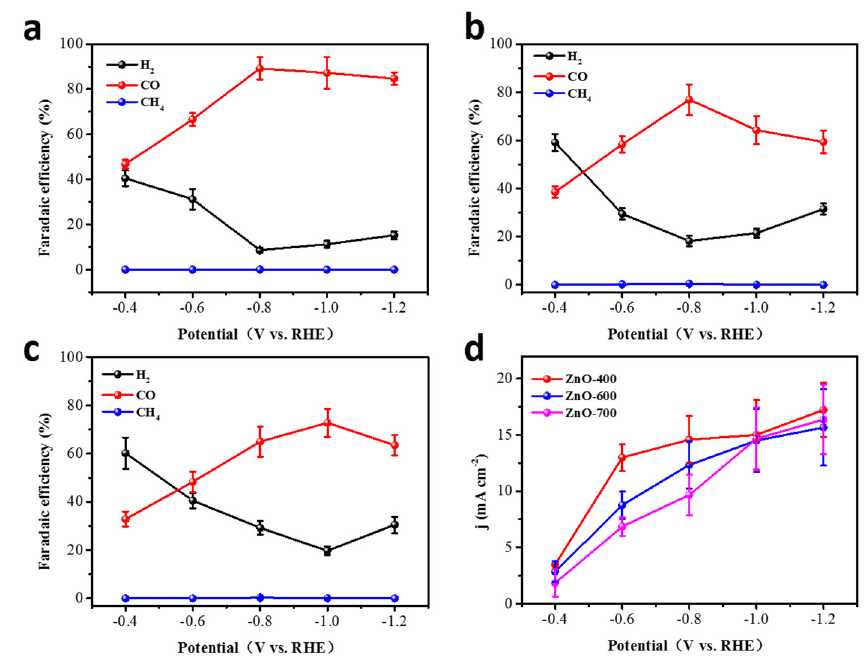
Figure 4. Faradaic efficiency on ( a ) ZnO-400, ( b ) Zn-600, and ( c ) ZnO-800. ( d ) The total current density of products on different ZnO catalysts.